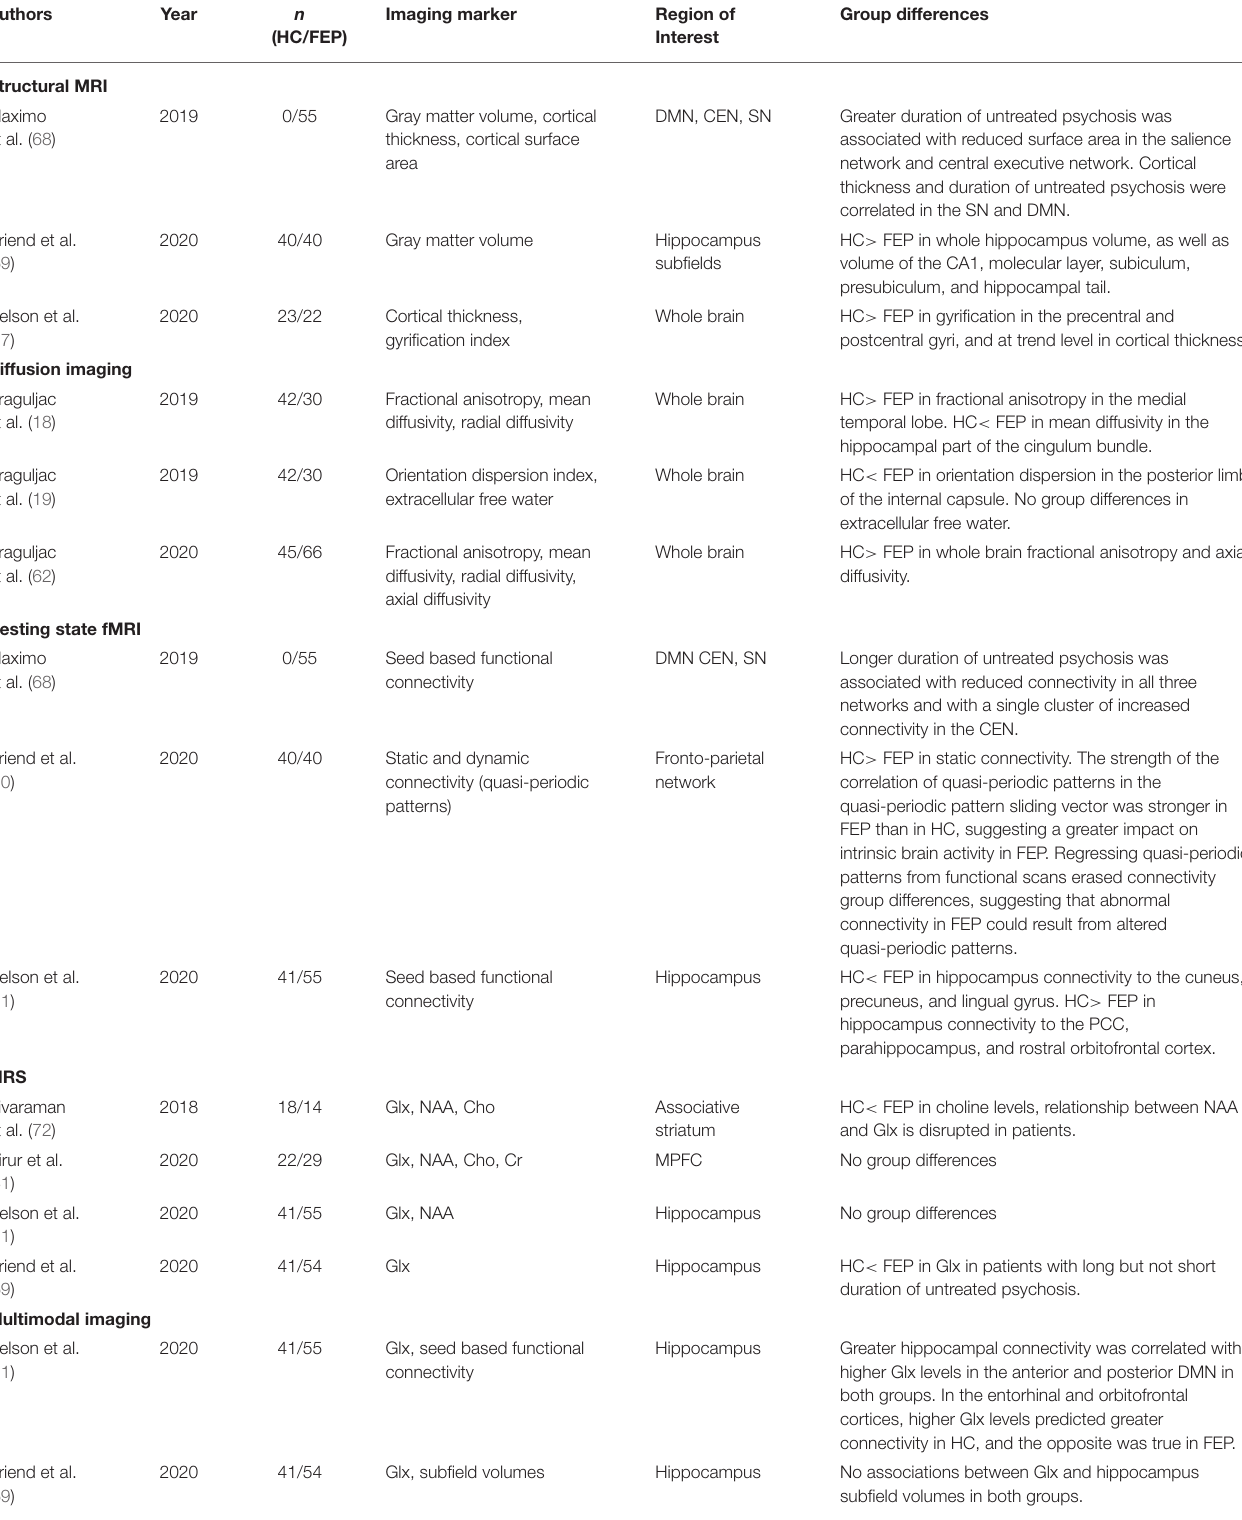
TABLE 3 | Neuroimaging studies of antipsychotic medication-naïve first episode psychosis patients from our group.